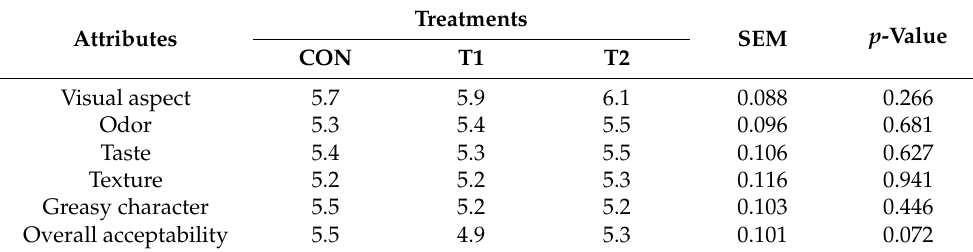
Table 5. Acceptance test results for the foal p â t é s.